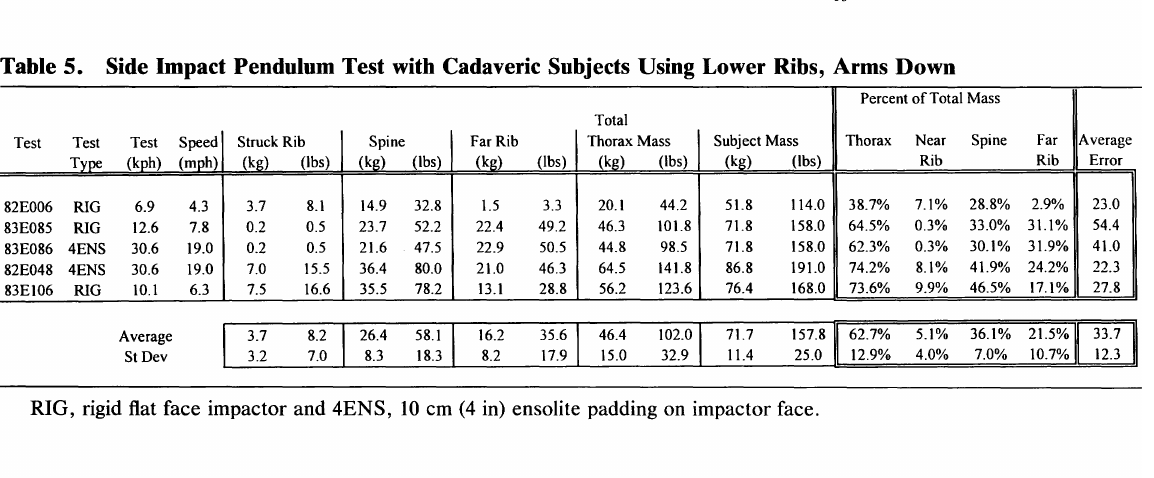
Table 5. Side Impact Pendulum Test with Cadaveric SUbjects Using Lower Ribs, Arms Down Test